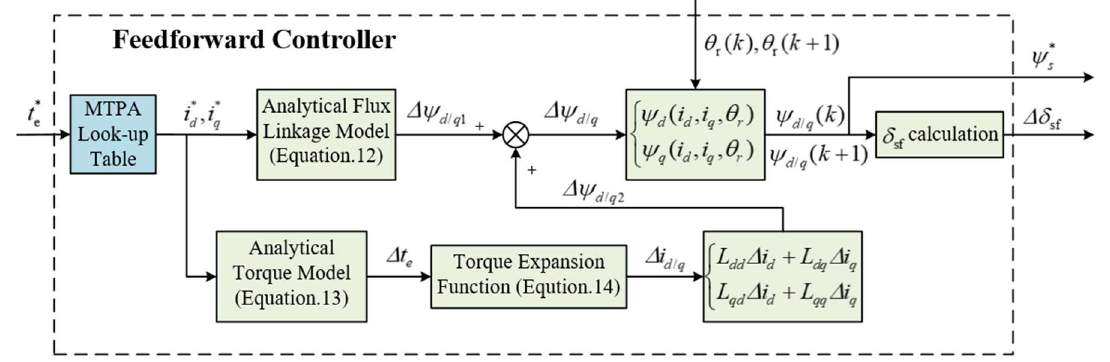
Figure 2. Flux linkage feedforward calculation module.